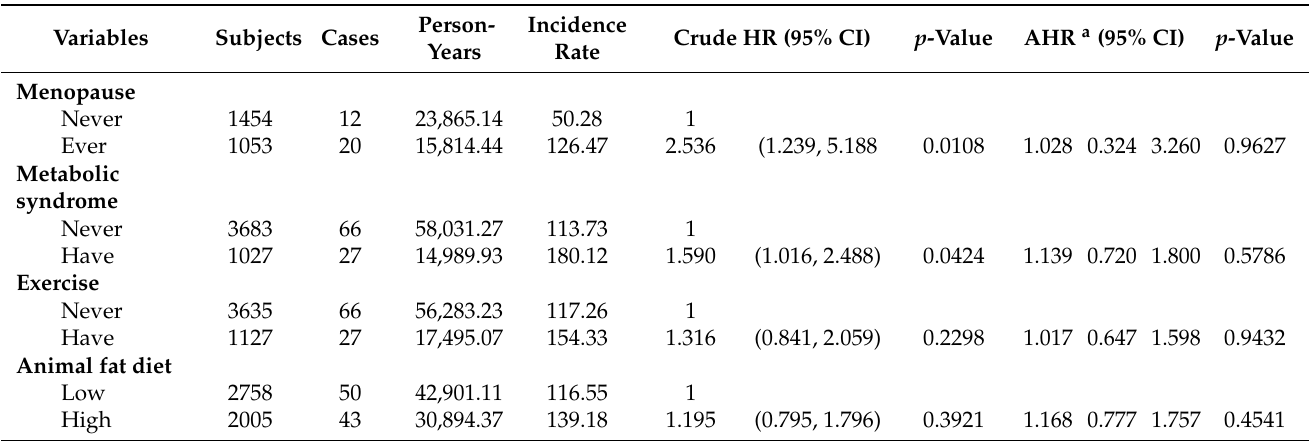
Table 3. Combination effects for cholesterol, triglyceride (TG) level, and colorectal cancer risk in DM and non-DM group.